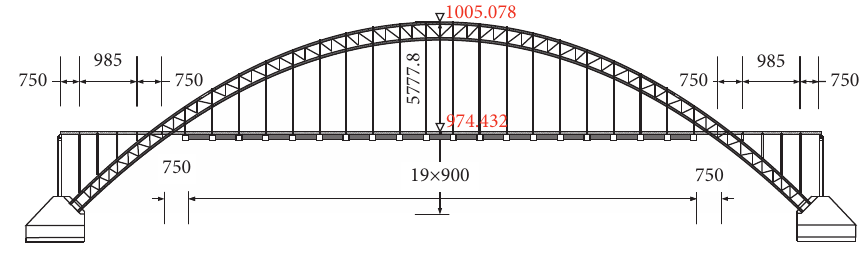
Figure 4: Bridge elevation structure drawing.